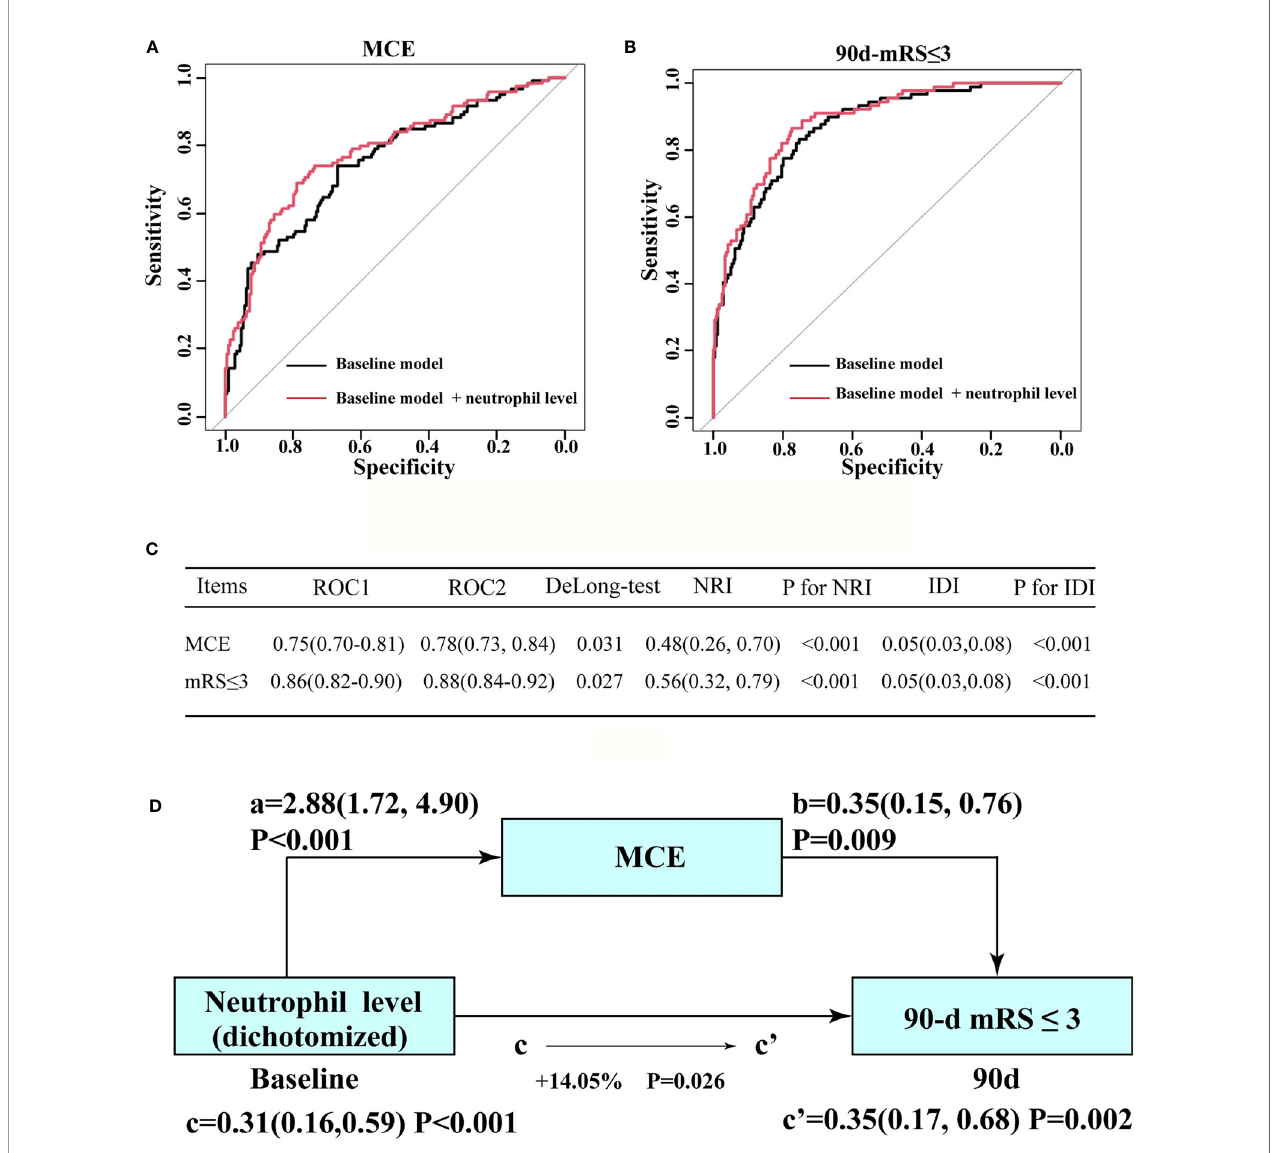
FIGURE 3 | Incremental effect of the neutrophil count level on the predictive value of the baseline model for favorable outcome and MCE. (A) ROC curves for baseline model and novel model count level when predicting long-term outcome. (B) ROC curves for baseline model (ROC1) and novel model (ROC2: adding neutrophil count level into the baseline model) when predicting MCE. (C) Results from DeLong ’ s test, the NRI, and IDI by comparing ROC curves in (A, B) , separately. (D) Mediation analysis by MCE of the associations between neutrophil count level and clinical outcome. a, regression coef fi cient of the association between neutrophil count and MCE; b, regression coef fi cient of the association between MCE and clinical outcome; c, regression coef fi cient of the association between neutrophil count level and clinical outcome; c ’ , regression coef fi cient of the association between neutrophil count level and clinical outcome, using neutrophil count level and MCE as additional independent variables. The percentage difference of the coef fi cients (1-c/c ’ ) is shown. a, b, c, and c ’ were evaluated by adjusted OR, taking the following variables into account: baseline NIHSS score, baseline PC-ASPECTS, mTICI, PC-CS score, occlusion sites, and onset to recanalization